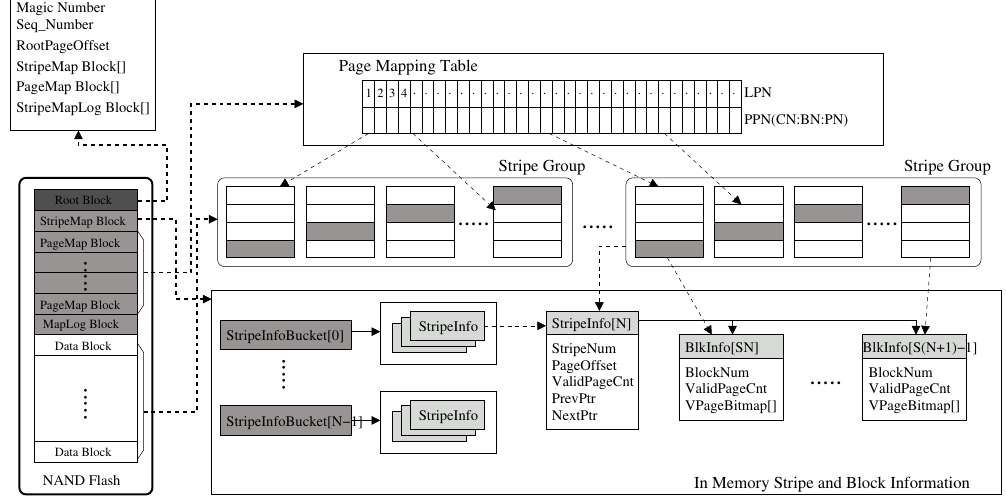
Figure 5. Software metadata structure for RAID and parity